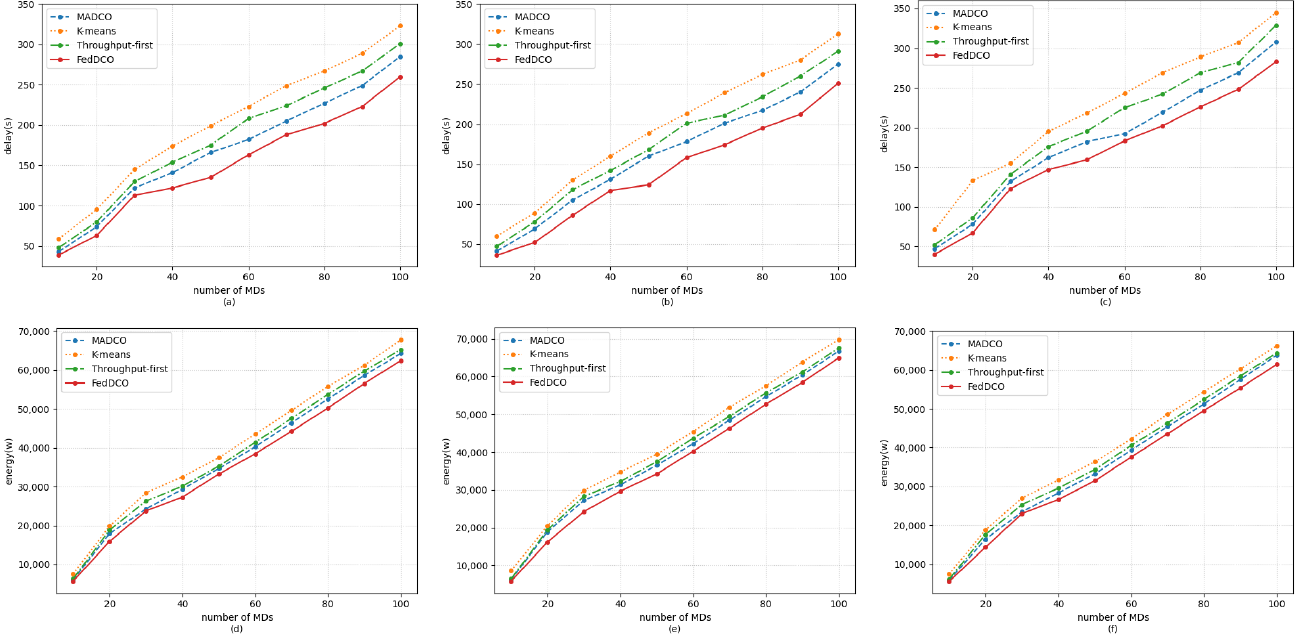
Figure 4. Comparison of network performance metrics at different MD quantities in different communication scenarios. ( a – c ) are the task processing delay in the general communication sce- nario, delay-sensitive scenario, and energy-sensitive scenario, respectively. ( d – f ) are the energy consumption in the general communication scenario, delay-sensitive scenario, and energy-sensitive scenario,